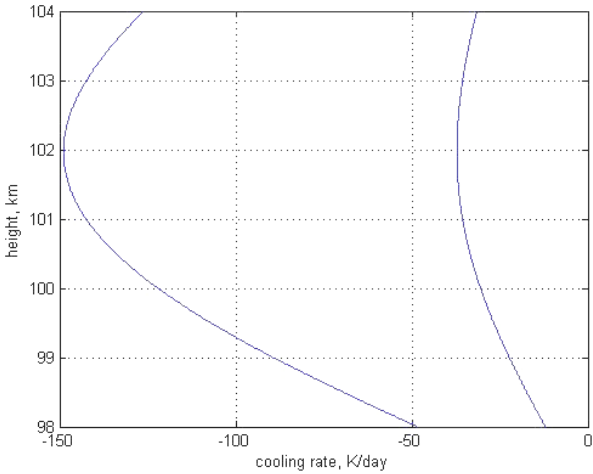
Fig. 11. Cooling rates calculated with the eddy diffusion shown in Fig. 3 in Hecht et al. (2004) (curve with the peak value of − 37Kday − 1 ) and with the eddy diffusion coefficient with K m 1 × 10 7 cm 2 s − 1 (curve with the peak value of − 150Kday − 1 ) cor- responding to the values given in Table 2 in Bishop et al.